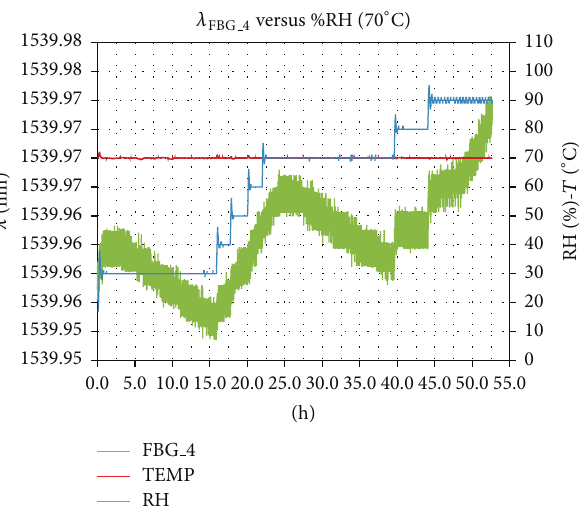
Figure 6: Bragg wavelength shift of FBG 4 (green, left axis) as a function of %RH (blue, right axis) at a temperature of 70 ∘ C (red, right